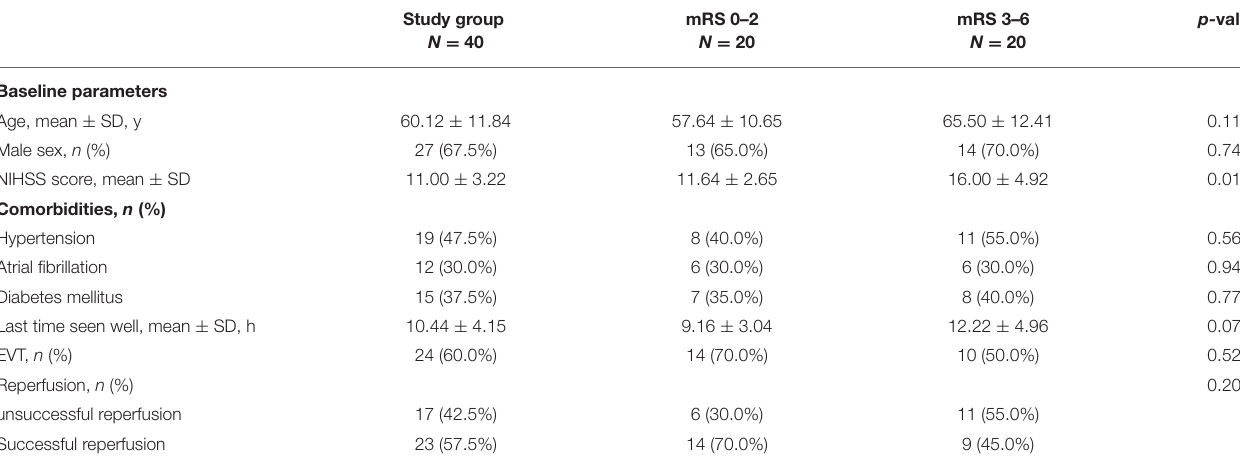
TABLE 1 | Patient characteristics ( n = 40).